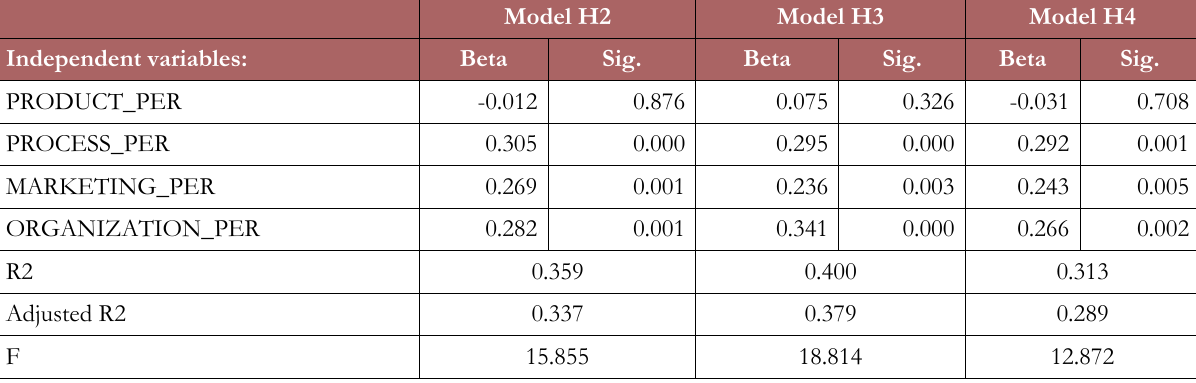
Table 5. Regression analysis results for branch